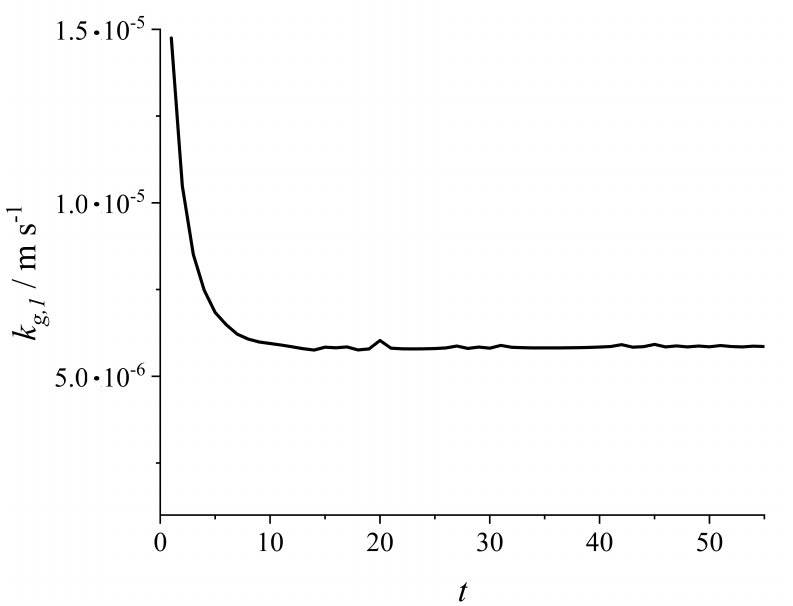
Figure 5. Time dependent overall mass transfer coefficient k g ,1 retrieved from the simulative study in Figure 5 with diffusion coefficient ratios of D 1 / D 3 = D 2 / D 3 = 0.3 (dotted